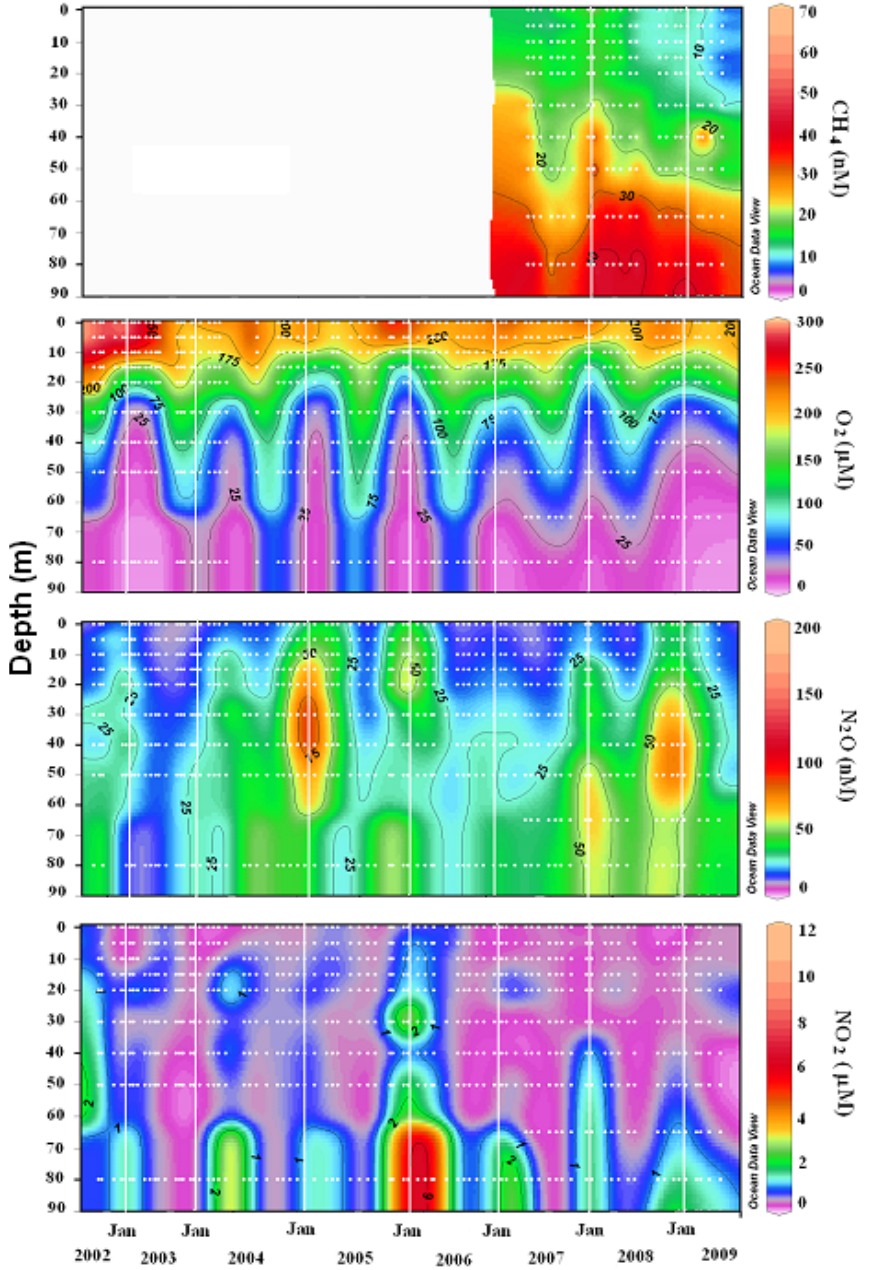
Fig. 7. Temporal variability of (a) CH 4 , (b) O 2 , (c) N 2 O; and (d) NO − Chile at a water depth of ∼ 90m. Data are from Farias el al. (2009b) for CH 4 and from Cornejo et al. (2007) for other